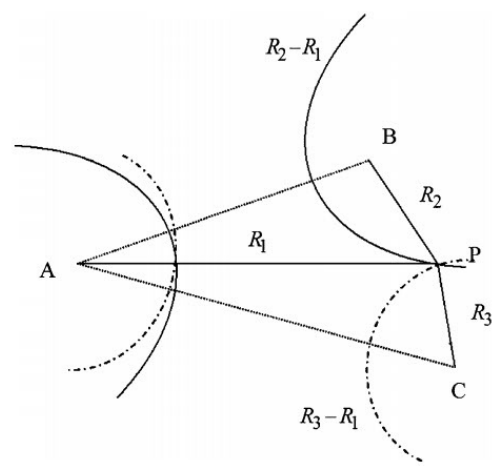
Figure 6. Positioning based on time difference of arrival